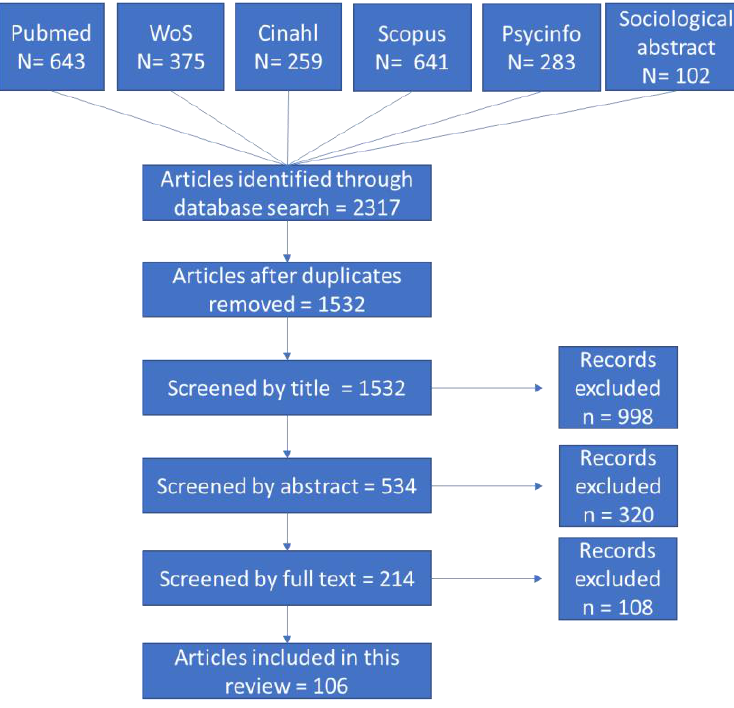
Figure1. Figure 1. Preferred Reporting Items for Systematic Reviews and Meta-Analyses (PRISMA) flow diagram.